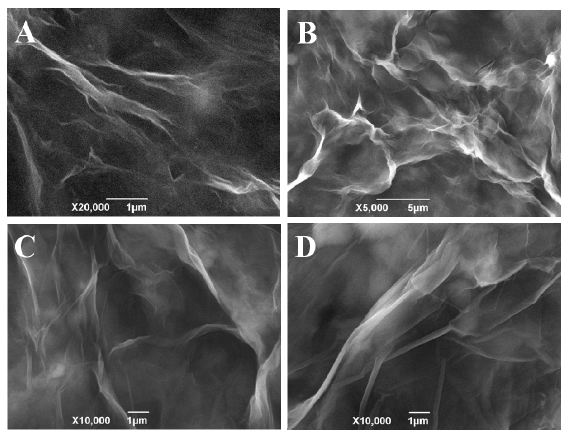
Figure 1. SEM images of product with different reaction concentrations of graphene oxide (GO) for 15 days: ( A ) 1 mg/mL; ( B ) 2 mg/mL; ( C ) 4 mg/mL and ( D ) 6 mg/mL.